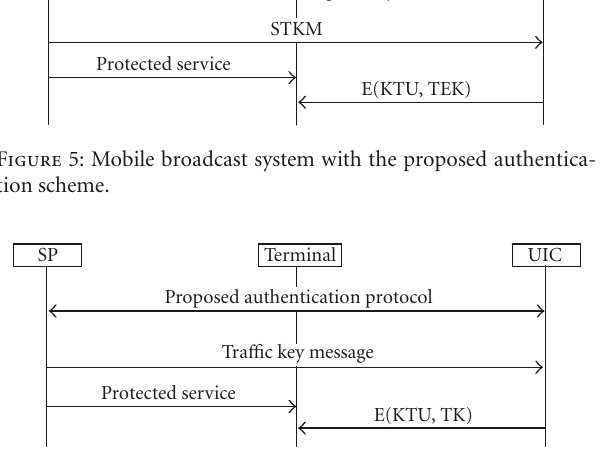
Figure 6: The terminal change and the proposed authentication